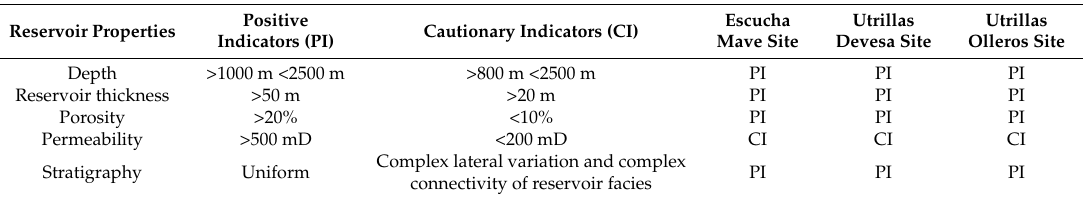
Table 6. Key geological indicators for storage site suitability [13] and their assessment for the studied rock types and potential reservoir structures (Figure